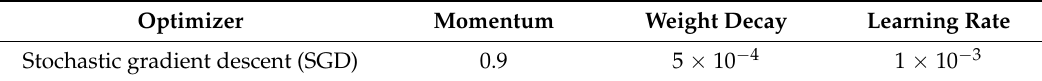
Table 1. Optimizer and hyperparameter settings before training.